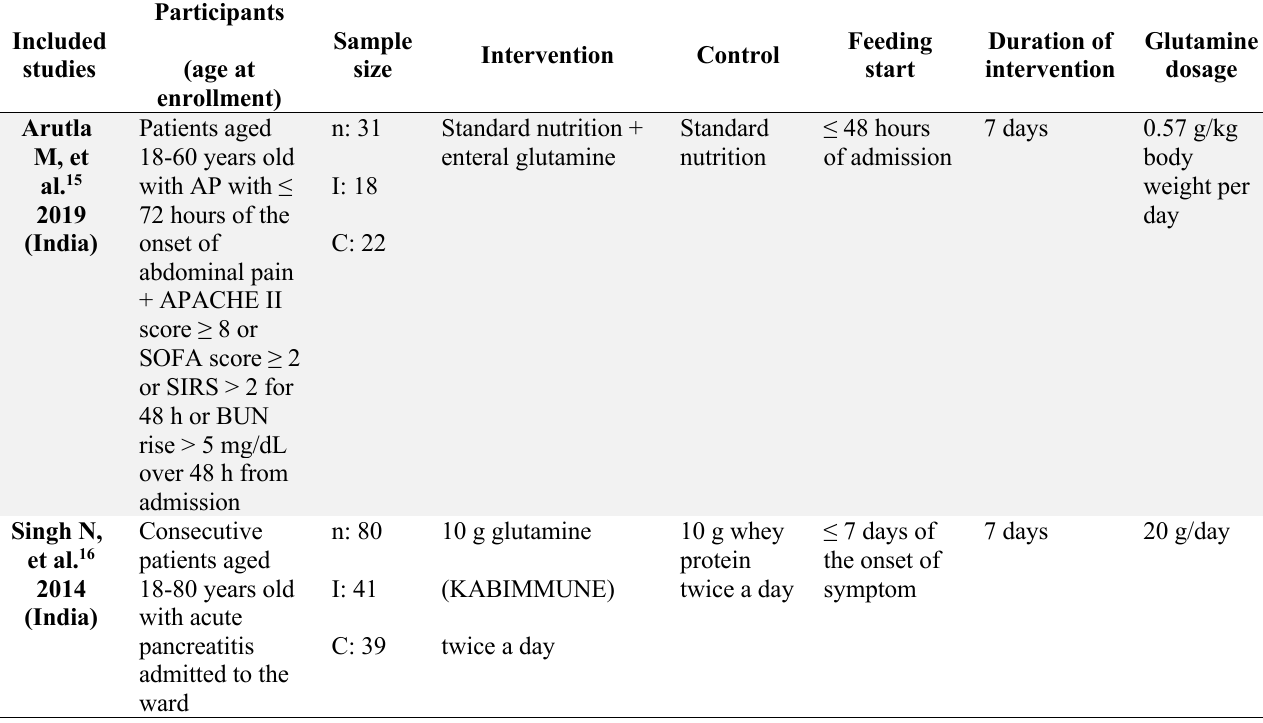
Table 3 . Characteristic of the included studies assessing the effect of enteral glutamine supplementation on intestinal permeability in acute pancreatitis